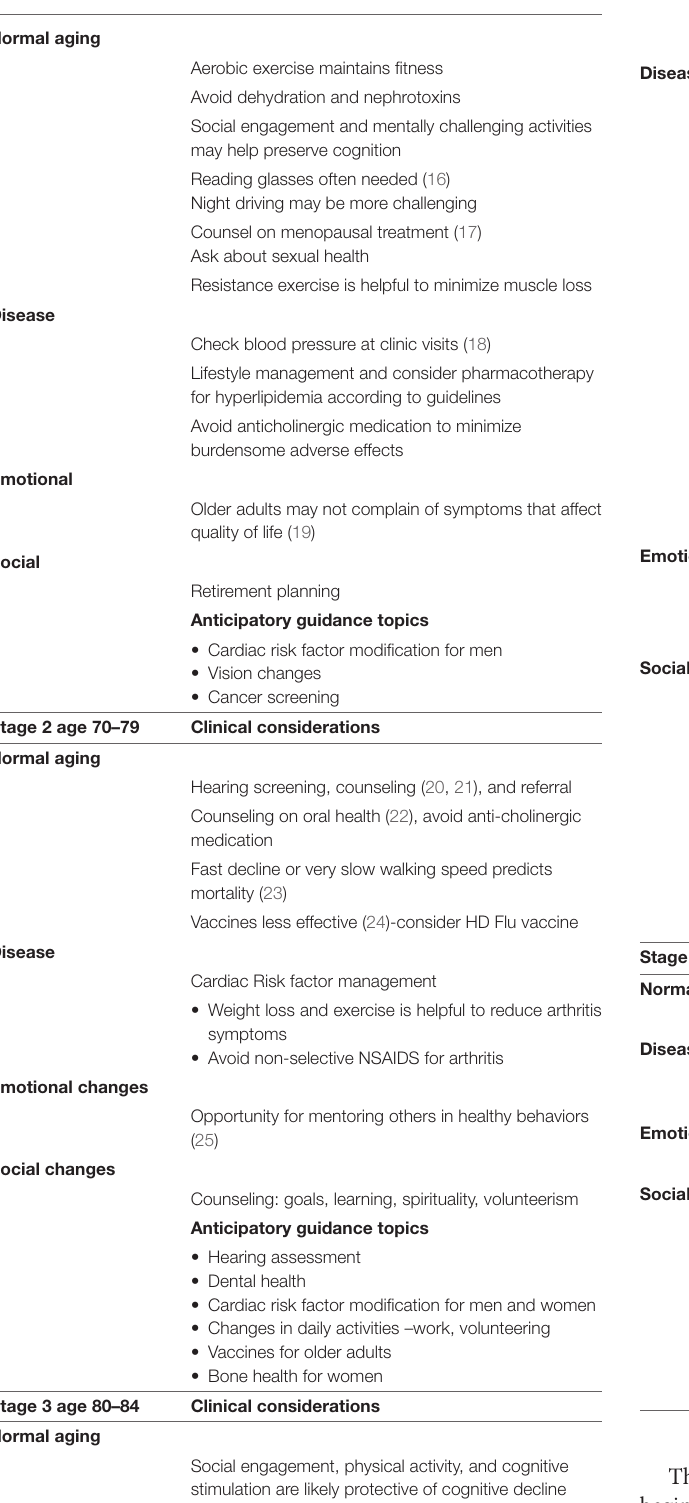
TABLE 1 | Chronological age strata with appropriate clinical considerations and anticipatory guidance topics. Stage 1 age